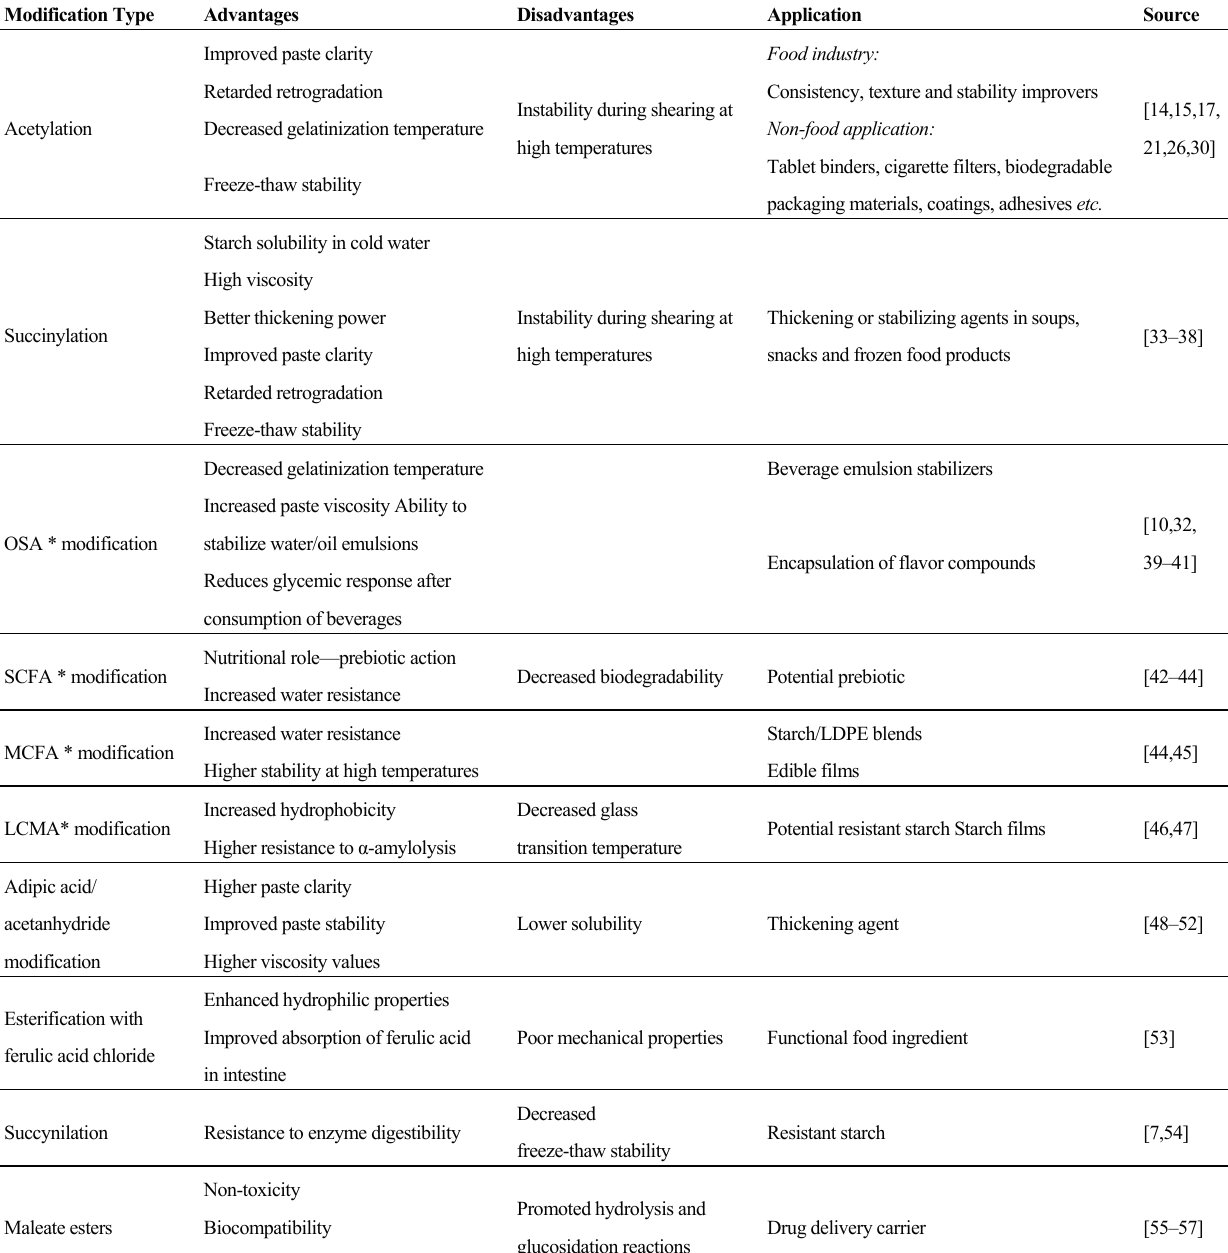
Table 1. Summary of starch modifications with organic acids and their derivatives.